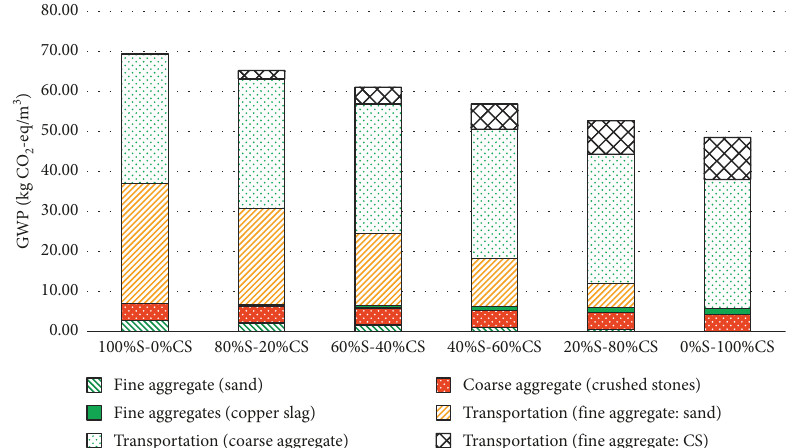
Figure 5: Distribution of GWP results for concrete aggregates (cement impacts are excluded), GreenConcrete LCA tool [3].